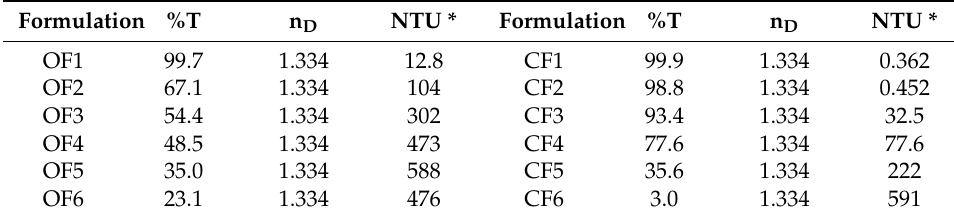
Table 4. Percentage transmittance (%T), refractive index (n D ) and turbidity (NTU) of formulations OF1–OF6 and